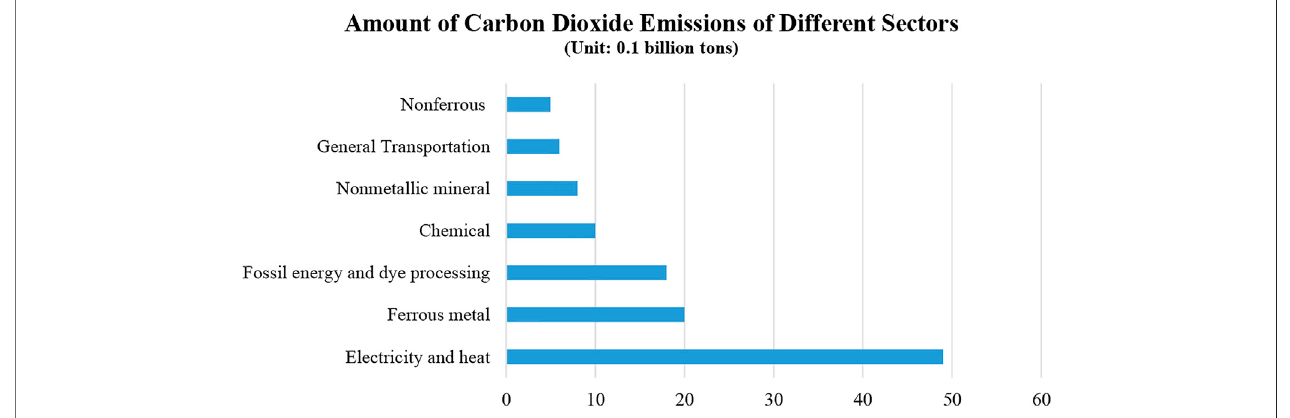
FIGURE 3 | Amount of carbon dioxide emissions of different sectors 4